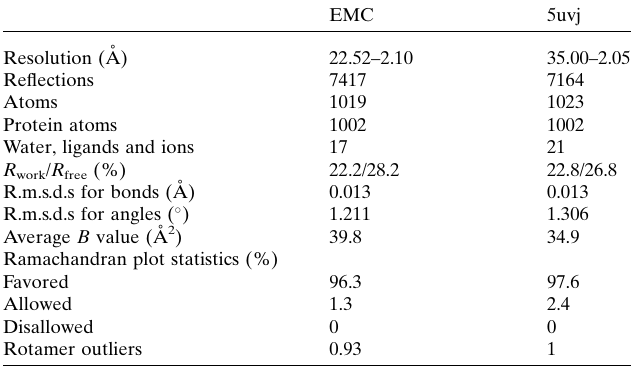
Table 1 The refinement statistics of our structure solution and the structure solved by Martin-Garcia et al. (2017) (PDB entry 5uvj).